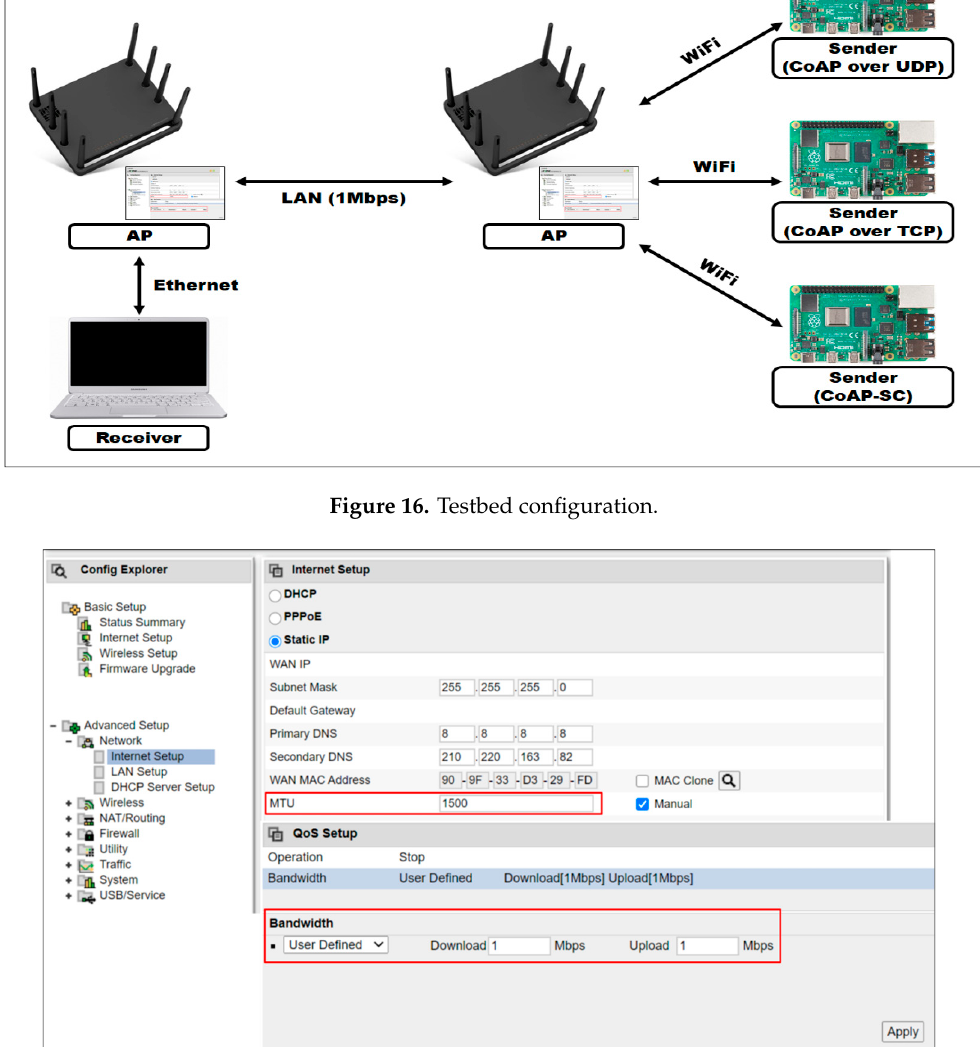
Figure 17. AP configuration and error event generation.